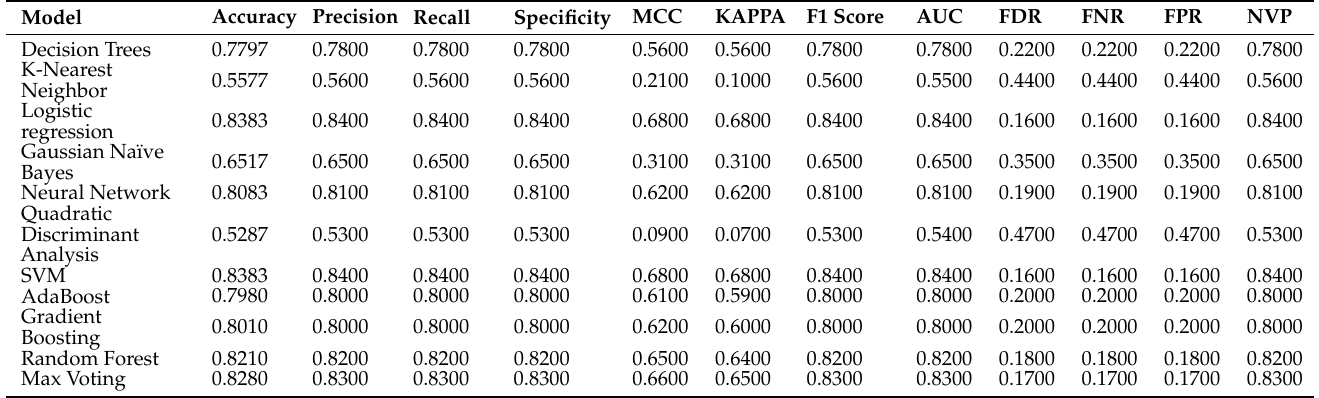
Table 7. Result of Dataset 4 using the Machine Learning Algorithms and Ensemble learning meth- ods.